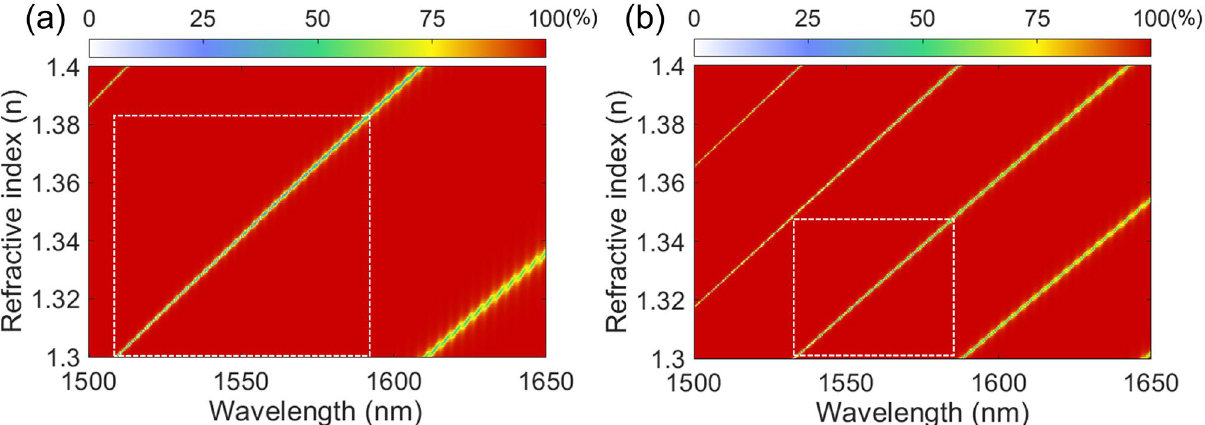
Figure 6. Calculated reflectance contour map as a function of wavelength and refractive index for a cavity thickness of ( a ) 7.8125 µm and ( b ) 15.6250 µm. The white-dash box indicates the region where only one resonance mode can be found within the wavelength range as the refractive index